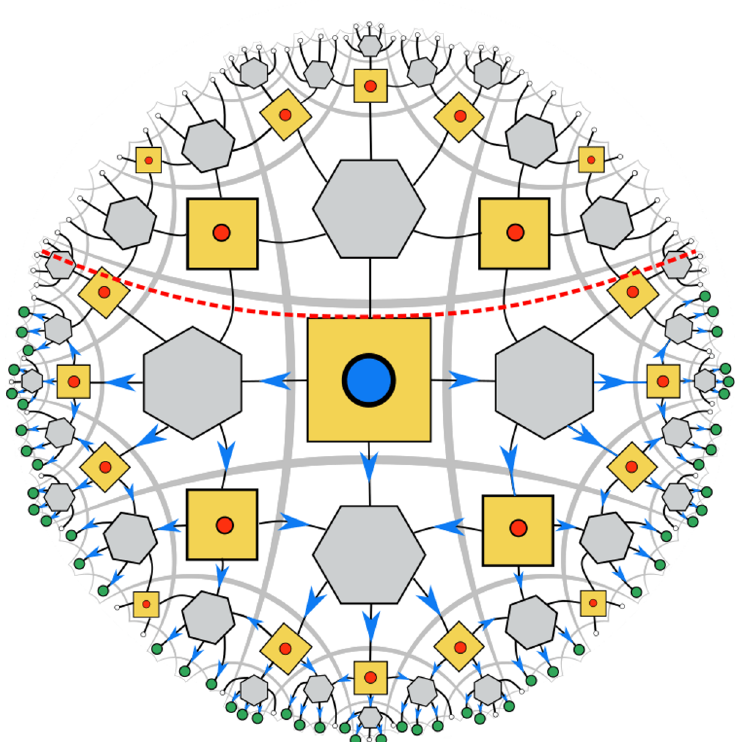
Figure 18. The bulk operator on the central tensor can be supported on a single connected interval on the